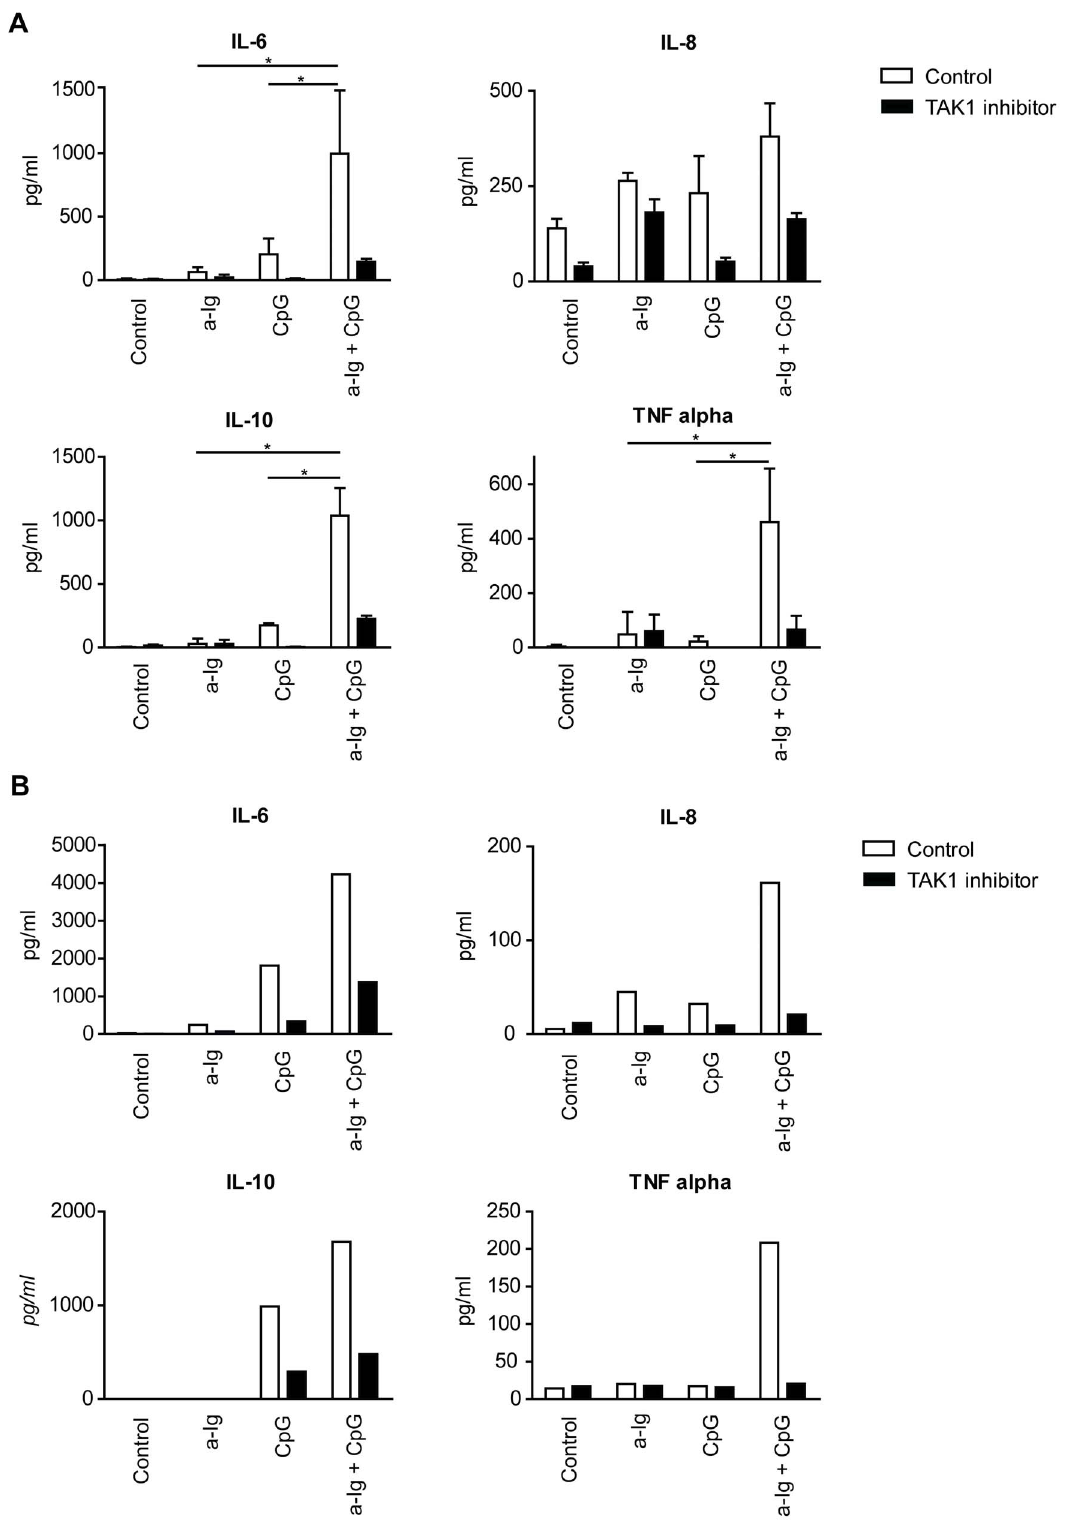
Figure 5. BCR synergizes with TLR9 on a TAK1 dependent manner for cytokine production in primary human B cells. Secreted IL-6, IL- 8, IL-10 and TNF a were measured after 48 h from culture supernatants of vehicle treated (white bars) and TAK1 inhibitor treated (black bars) purified human tonsill (A) and blood (B) B cells. Data represent the mean 6 SD of three different experiments with resting tonsill B cells (A), while one experiment with blood B cells (B) is shown. *p , 0.05.